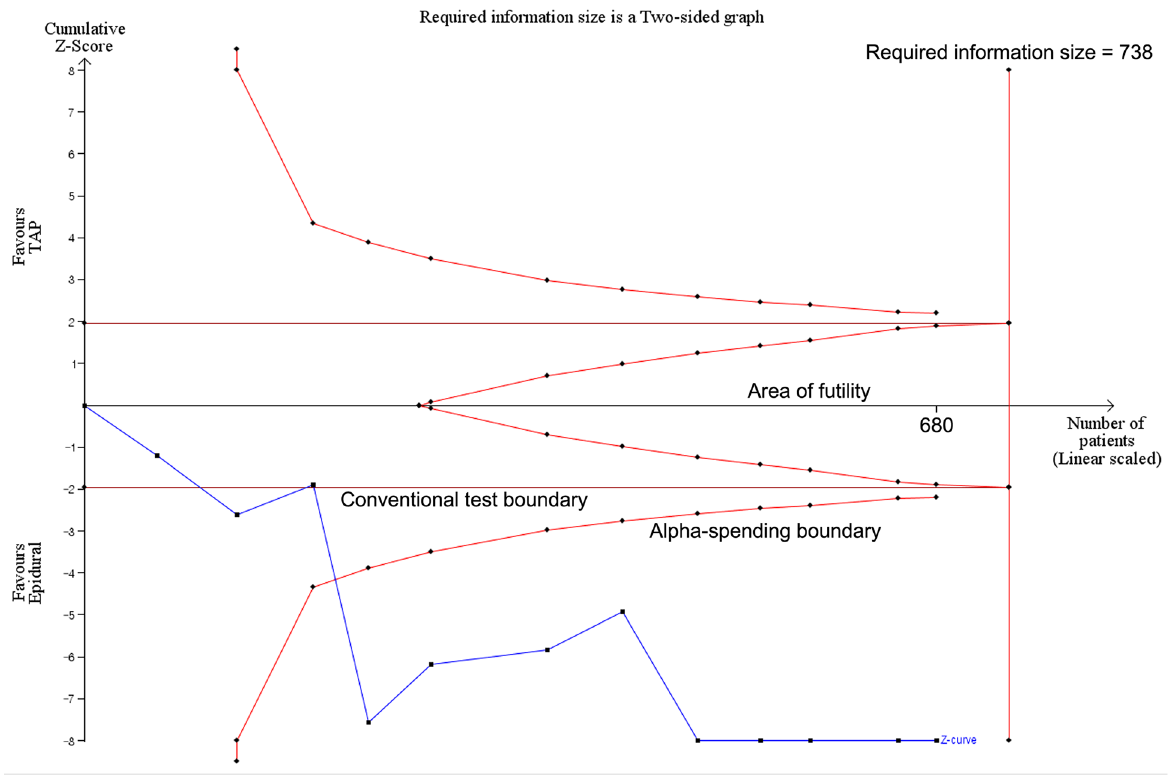
Figure 5. Trial sequential analysis for the pain score at rest at 12 h.